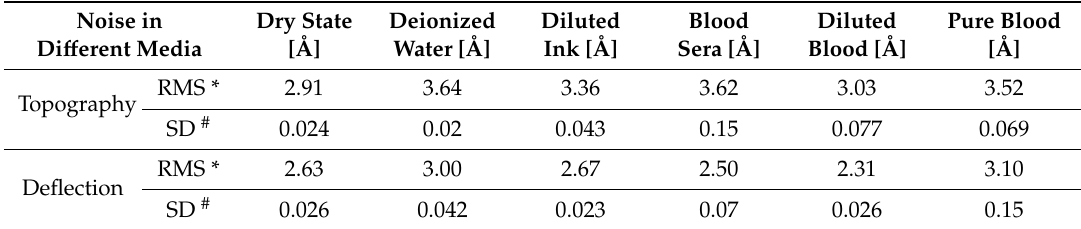
Table 1. Comparison of z-noise values recorded in di ff erent